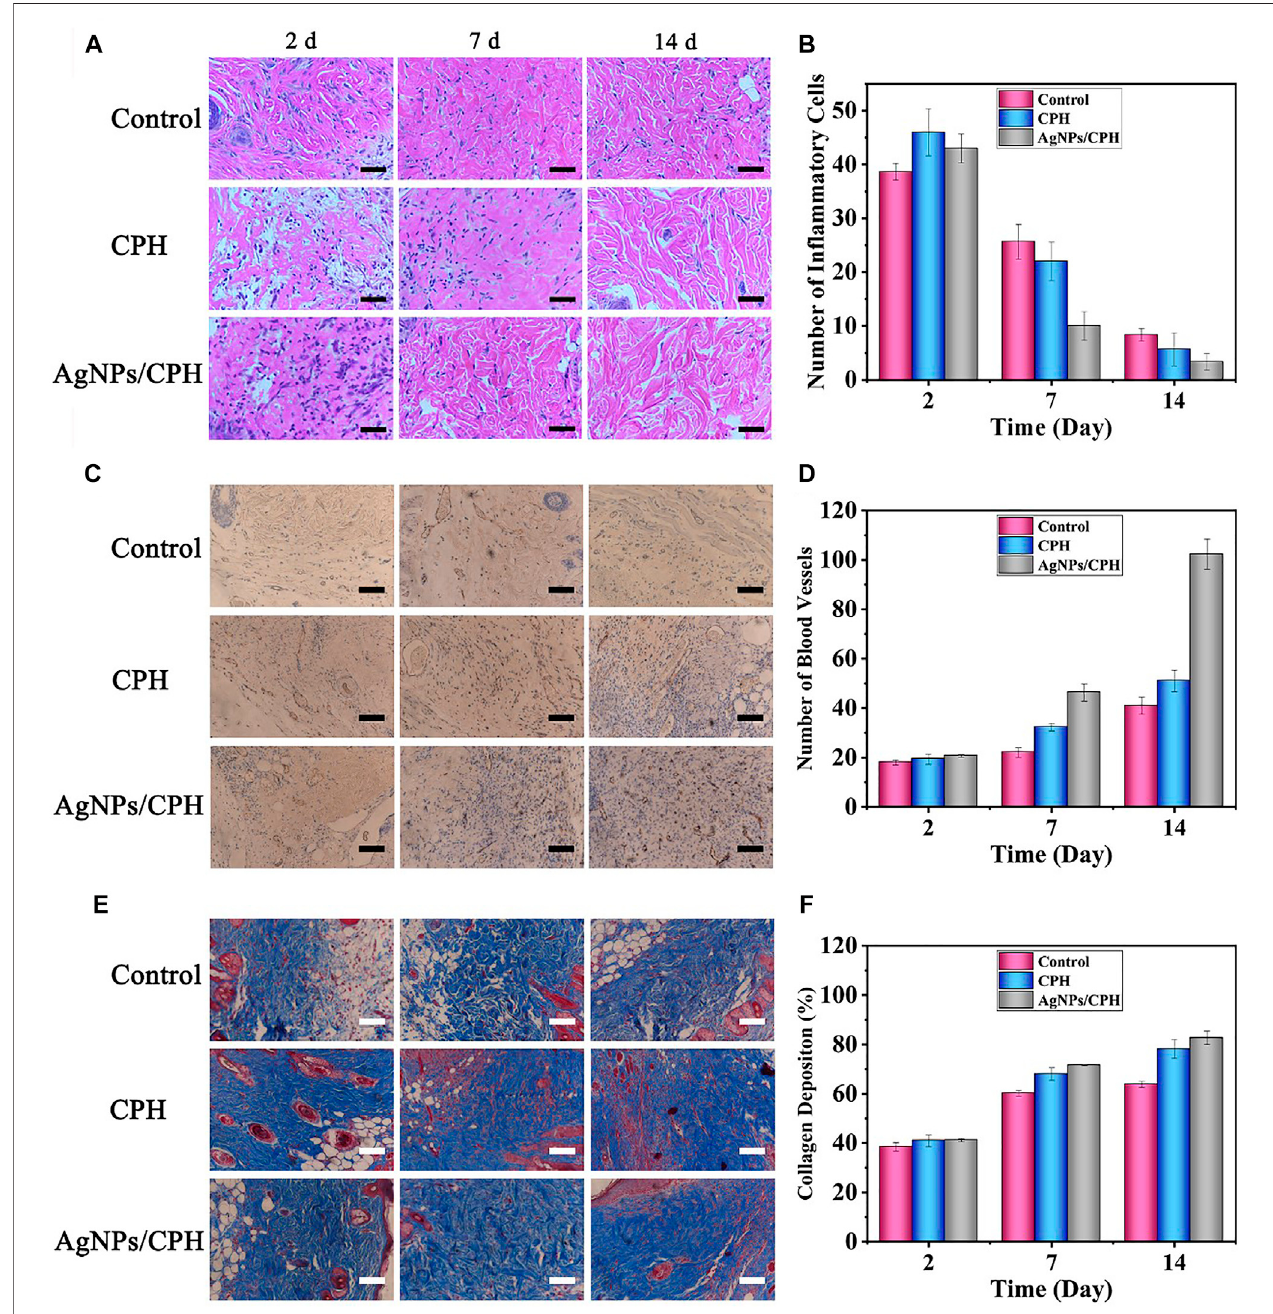
FIGURE 6 | (A) H&E-stained sections of skin tissue near the wound of mice treated with gauze (control group), CPH, and Ag NPs/CPH after 2, 7, and 14 days (scale:50 μ m). (B) Correspondingcountofin fl ammatorycells. (C) CD31-stainedsectionsofskintissuenearthewoundofmicetreatedwithgauze(controlgroup),CPH, and Ag NPs/CPH after 2, 7, and 14 days (scale: 100 μ m). (D) Corresponding count of blood vessels in Figure 6C . (E) Masson-stained sections of skin tissue near the wound of mice treated with gauze (control group), CPH, and Ag NPs/CPH after 2, 7, and 14 days (scale: 100 μ m). (F) Corresponding percentage of collagen deposition in Figure 6E